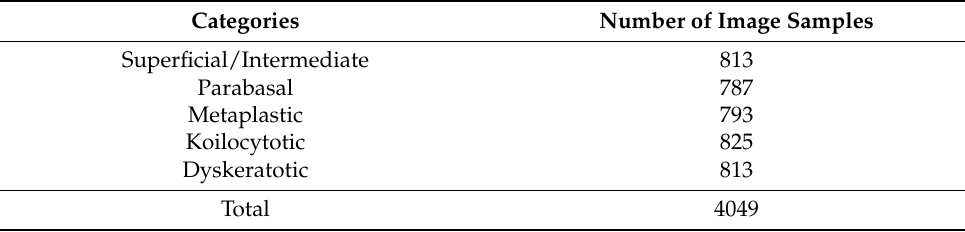
Figure 2. Samples categories from the SIPaKMeD dataset. Table 1. Data distribution of the cells in categories of SIPaKMeD dataset.